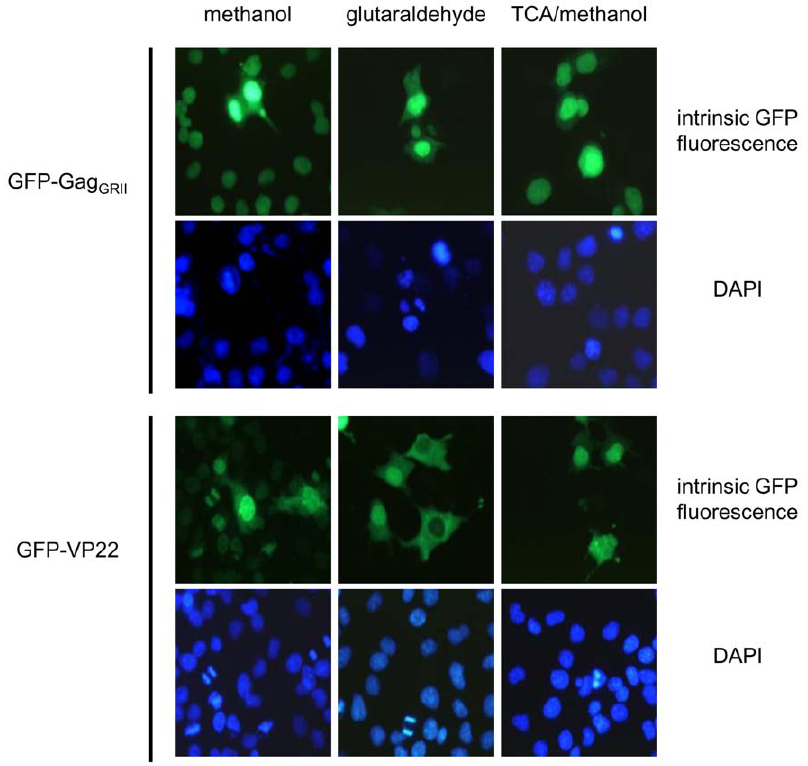
Figure 3. The fixation procedure influences the intercellular spreading of GFP-Gag GRII and GFP-VP22. Cells expressing GFP-Gag GRII or GFP-VP22 were fixed with methanol, glutaraldehyde or treated with TCA before fixation with methanol, as indicated. Cells were then analyzed for intrinsic fluorescence. Original magnification 6 40.